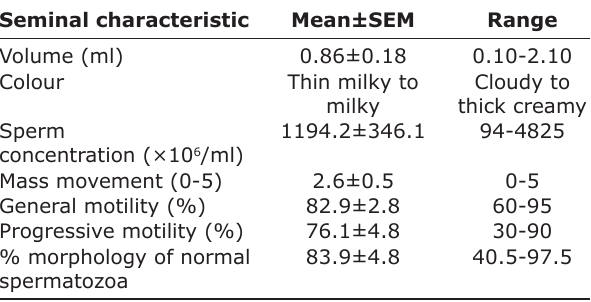
Table-1: Seminal characteristics of Rusa timorensis deer.